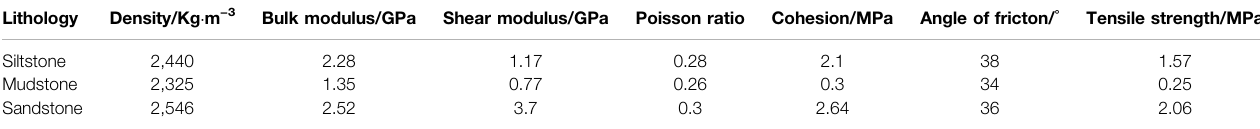
TABLE 2 | Physical and mechanical parameters of roadway surrounding rock.